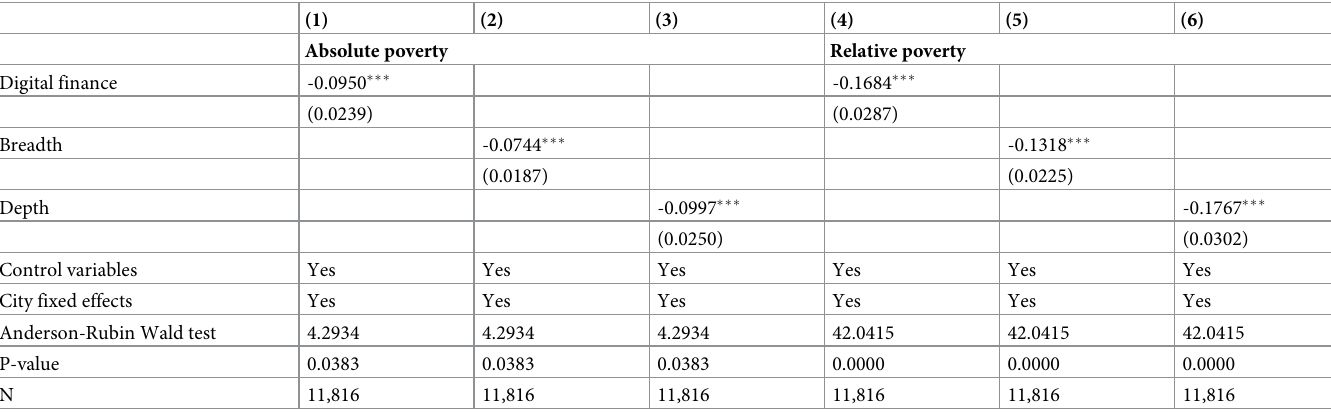
Table 17. The impact of digital finance on rural household poverty: IV methods (second-stage